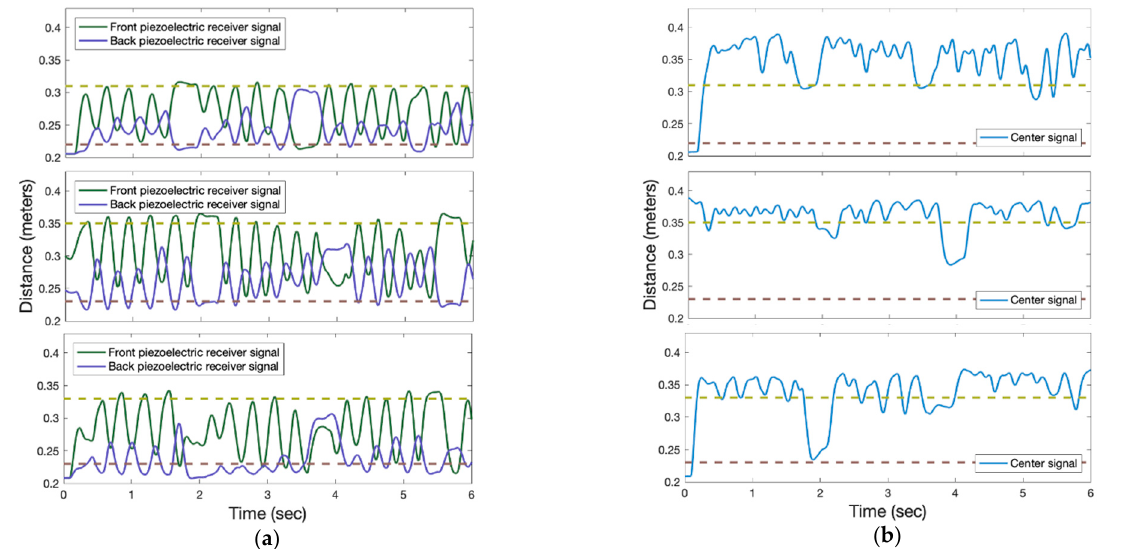
Figure 5. ( a ) Signals from front and back receivers for three trials. ( b ) Thresholding used on the center receiver signal to determine if the person is in-motion or static for three trials. Dashed lines represent the thresholds.